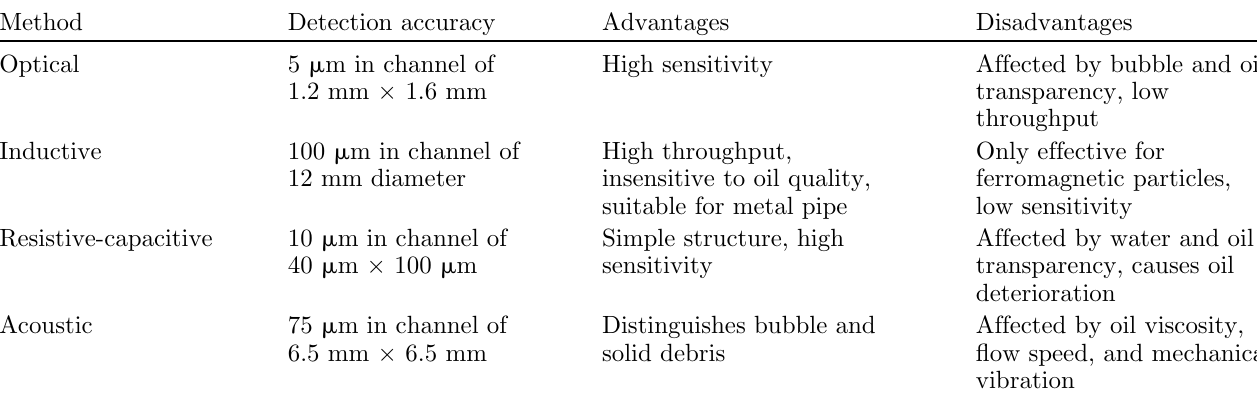
Table 1. Comparison of four wear debris monitoring